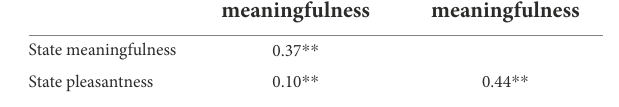
TABLE 2 Intercorrelations of trait meaningfulness, state meaningfulness, and state pleasantness. Variables